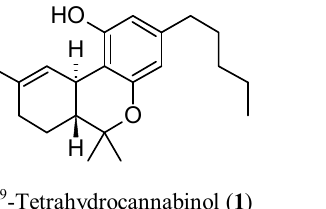
Figure 2. Chemical structures of N -arachidonoylethanolamine (anandamide, AEA, 3 ) and 2-arachi- donoylglycerol (2-AG, 4